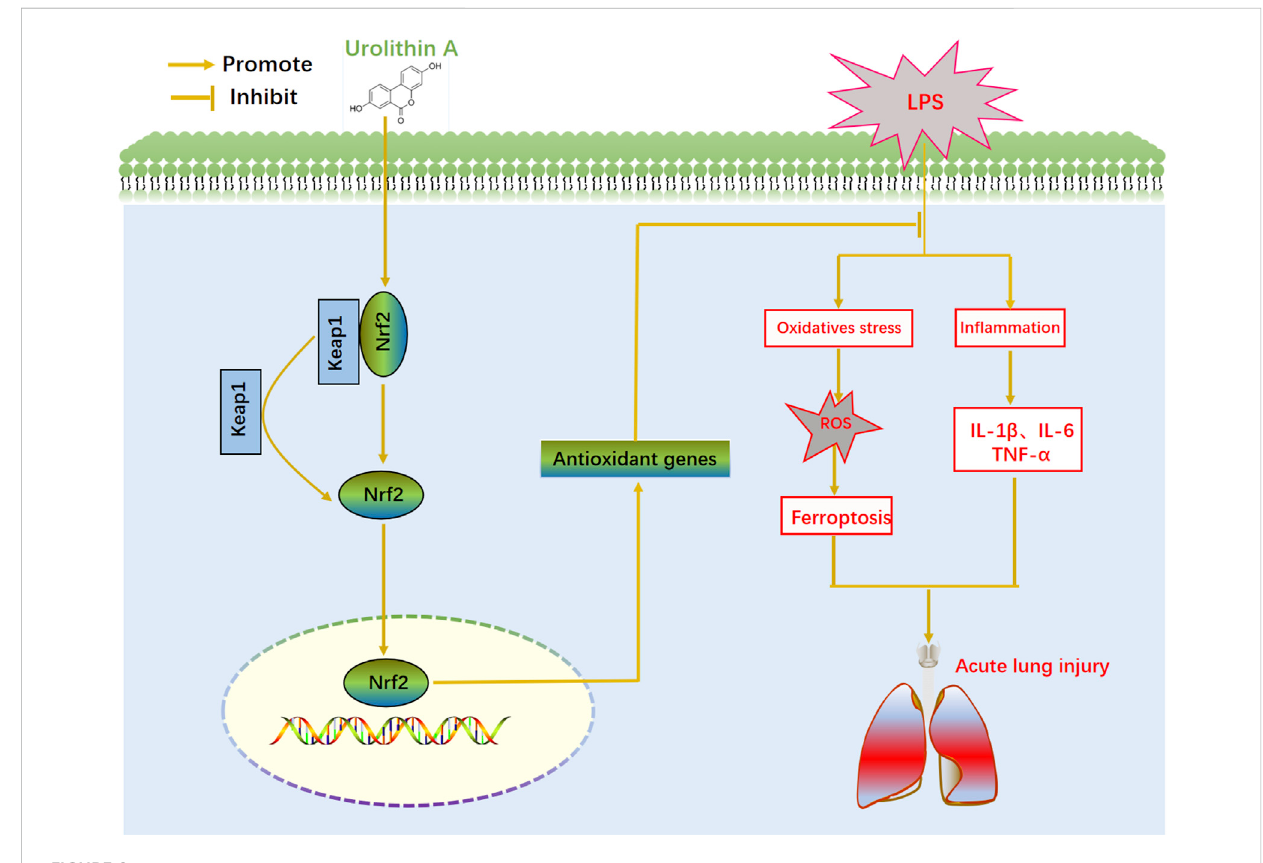
FIGURE 9 Schematic illustration of effect of UA in LPS-induced